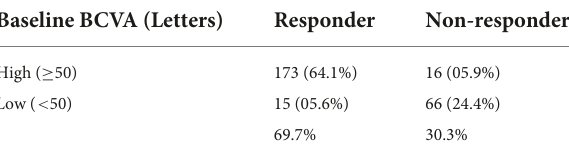
TABLE 1 Visual function responder/non-responder subgroups stratified by baseline (BSL) visual acuity. The number of patients and their prevalence is reported for each